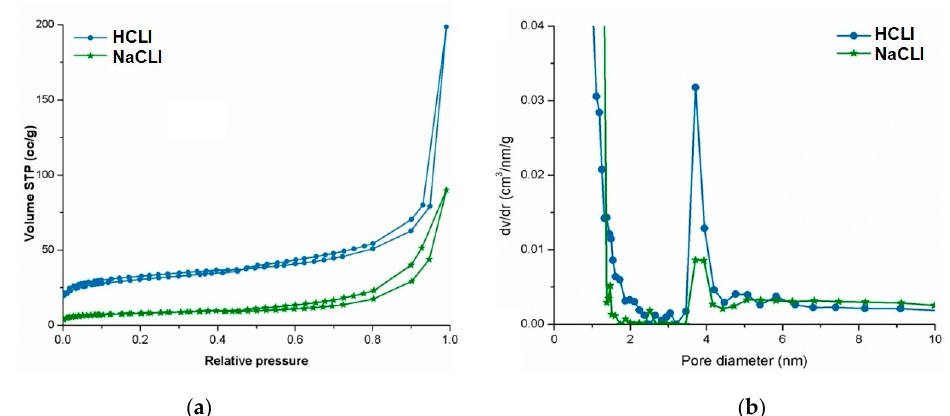
Figure 2. Clinoptilolite matrices: ( a ) N 2 -sorption isotherms; ( b ) pore size distribution curves. Clinoptilolite hydrogen form (HCLI), clinoptilolite sodium form (NaCLI).